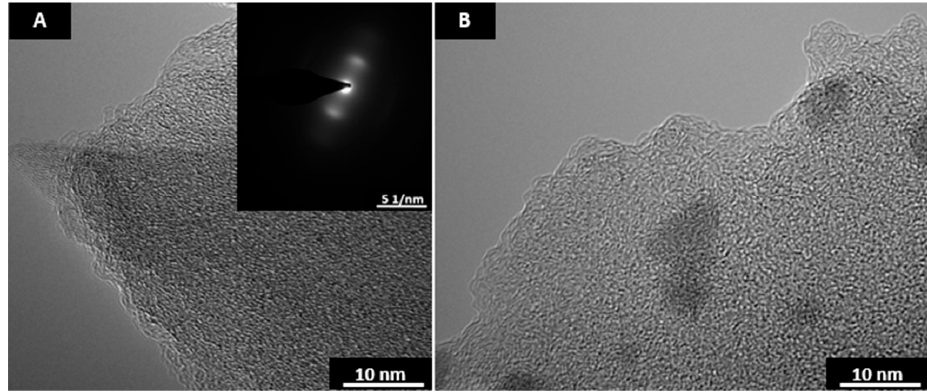
Figure 5. ( A ) TEM micrograph and SAED pattern of anthracene coke ( B ) and TEM micrograph of sucrose char after heat treatment at 1200 °C for 1s.